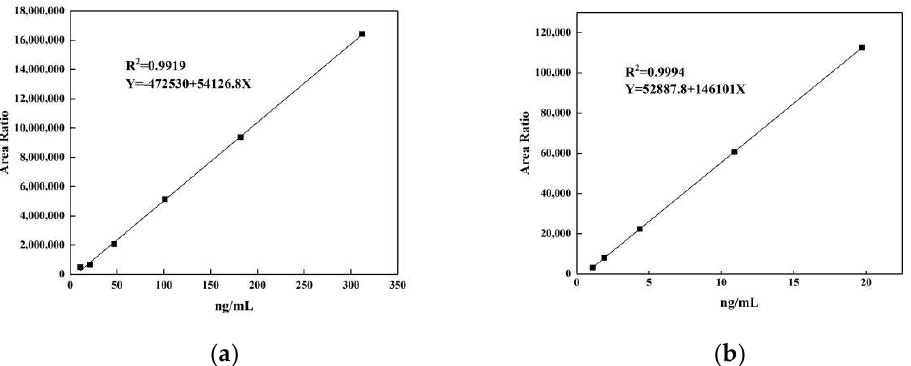
Figure 6. Standard curve of melamine solution at 10–300 ng/mL concentration ( a ); standard curves of three β-agonist mixture solutions at concentrations of 1–20 ng/mL ( b ).